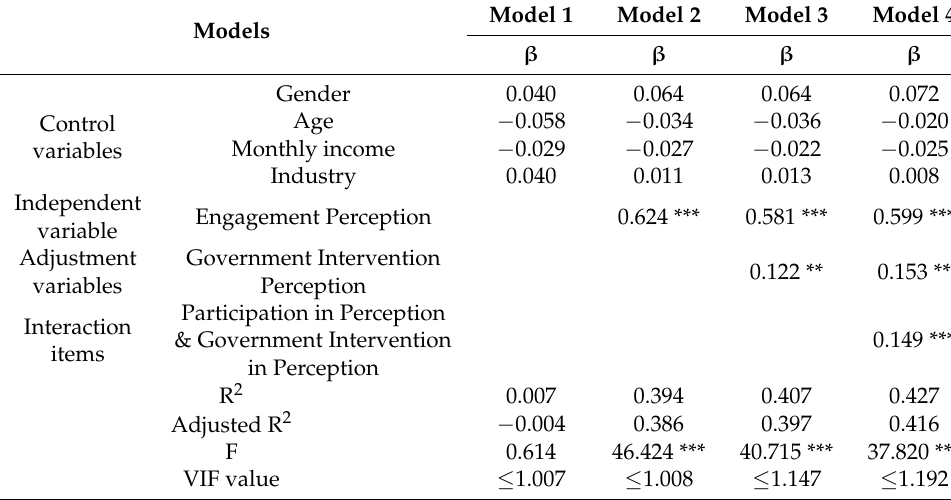
Table 14. Moderating role of perceived government involvement in perception of participation and willingness to perform. Model 1 Model 2 Model Models